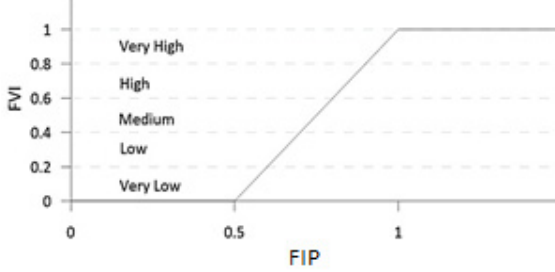
Figure 3. Assessment of the Flood Vulnerability Index (FVI) as a function of the flood intermediate parameter (FIP) [21]. parameter (FIP)